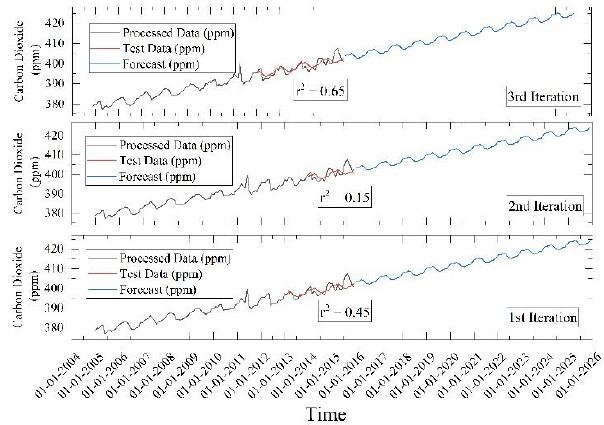
Figure 6: Forecast of Carbon dioxide from year 2016 to 2025 using three iterations according to different training periods. First iteration uses 8 years data for training and 2 years as test. Second iteration uses 9 years data for training and 1 years as test. Third iteration uses 7 years data as training and 3 years as test.